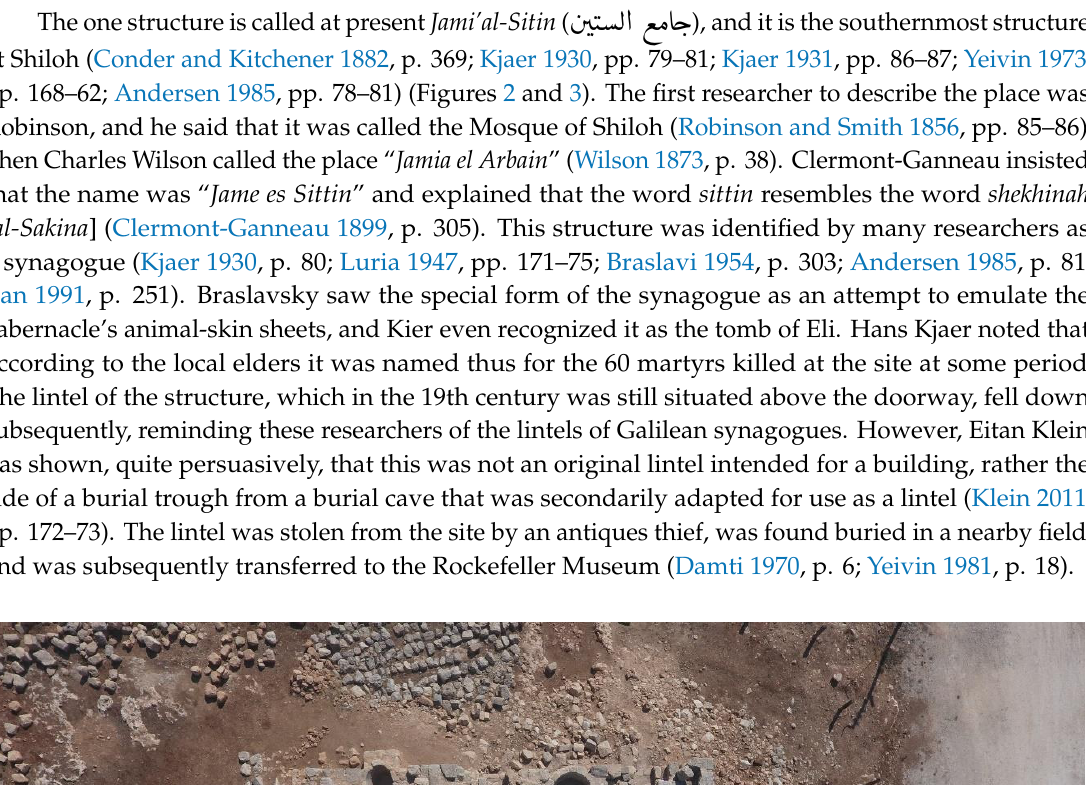
Figure 3. Jami ʿ al-Sitin and the polytheistic burial trough as lintel, from North. From the British Archive SRF_171